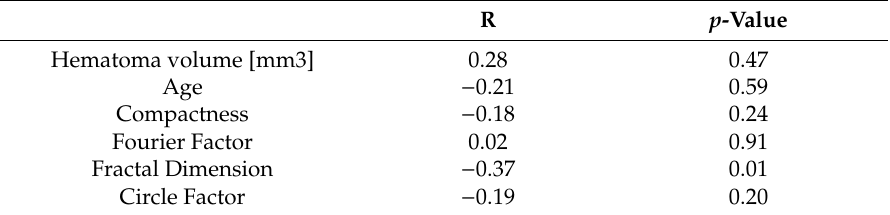
Table 4. Factors correlated with the Glasgow Coma Scale Score upon admission. R p -Value Hematoma volume [mm3] 0.28 0.47 −